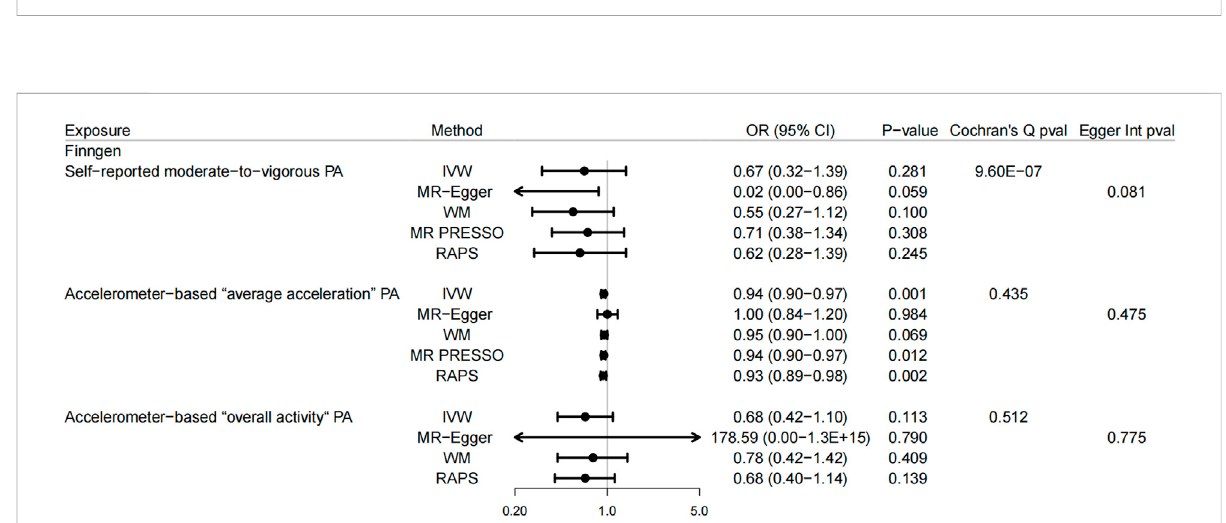
FIGURE 3 Mendelian randomization estimates from each method of assessing the causal effects of physical activity on gallstones disease in the FinnGen consortium data. Abbreviation: PA, physical activity; IVW, inverse-variance weighted; WM, weighted median; MR-PRESSO, MR pleiotropy residual sum and outlier; RAPS, robust adjusted pro fi le score; OR, odds ratio; CI, con fi dence